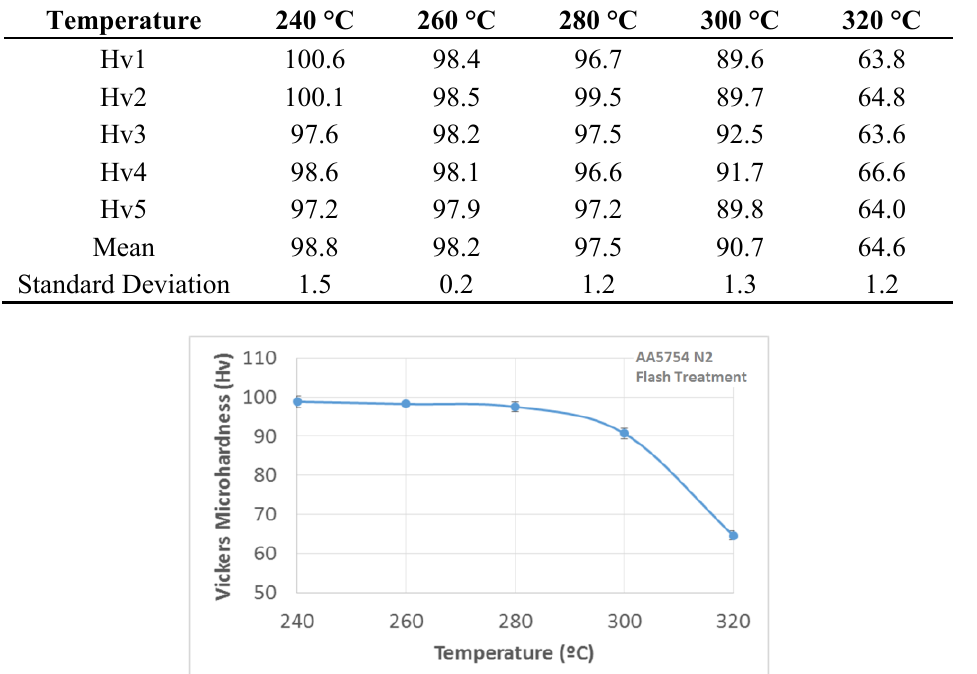
Table 3. Hv microhardness for the N2 state material after the flash treatment.